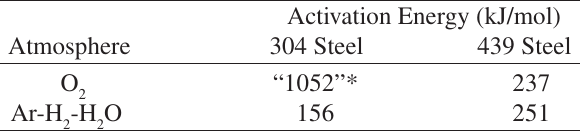
Table 3. Activation energies for oxidation.